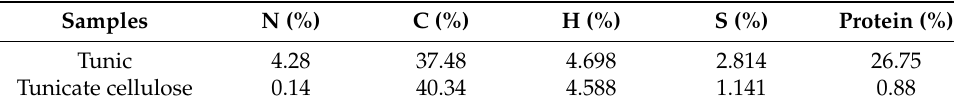
Table 1. Elemental analyses of tunic and tunicate